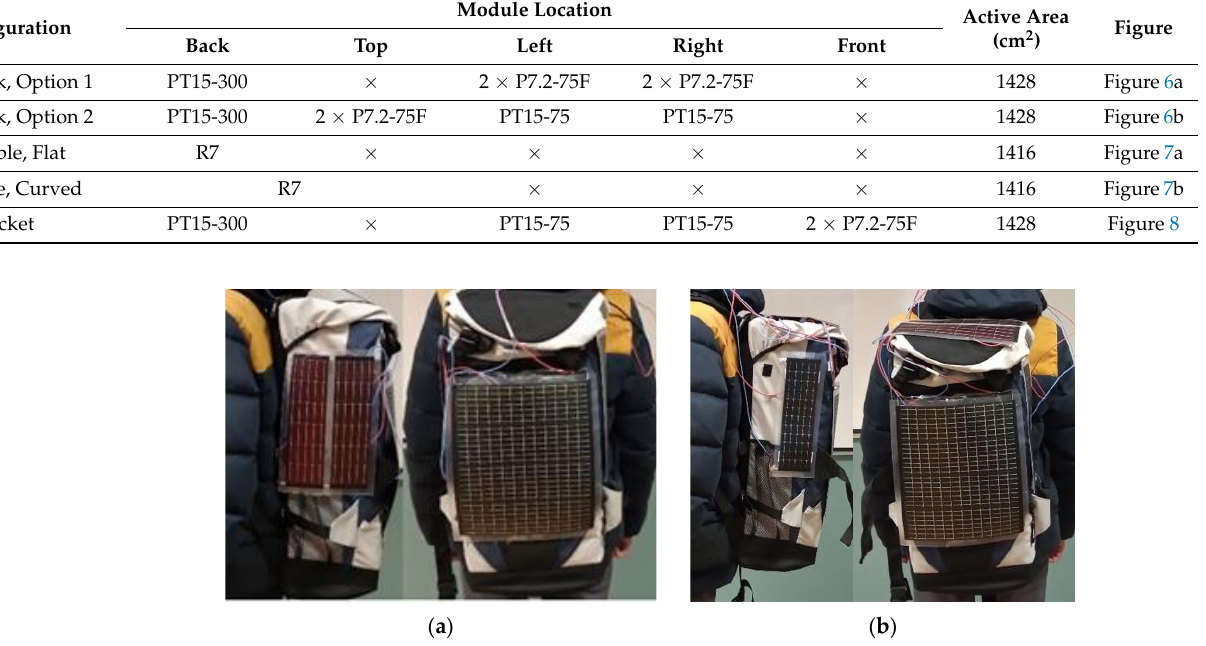
Figure 6. PV module configurations for a backpack: ( a ) Option 1; ( b ) Option 2.